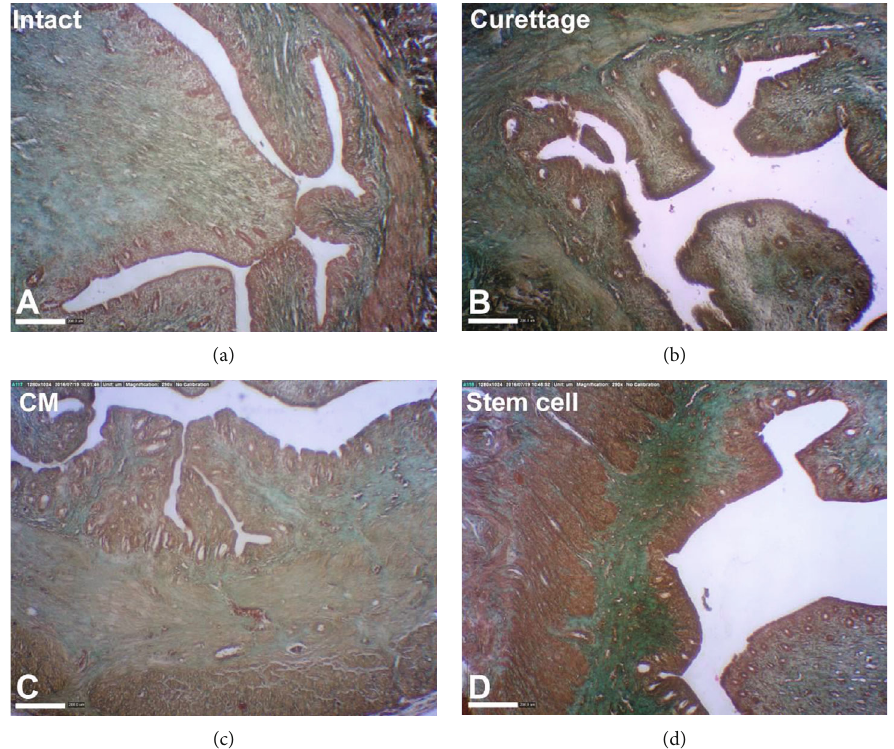
Figure 2: Histological evaluation of the preventive e ff ects of intrauterine bone marrow-derived mesenchymal stromal cell- (BM-MSC-) conditioned media (CM) injection on uterine fi brosis after endometrial curettage in rabbits (Masson ’ s trichrome staining). (a) The normal morphology of uteri was demonstrated in the intact group. (b) In the curettaged group, uteri were with moderate abnormal morphology and thinner endometrium after 30 days. (c) The treatment group after injection of BM-MSC-CM after 30 days. (d) The treatment group after injection of BM-MSC after 30 days ( scale bars = 200 μ m